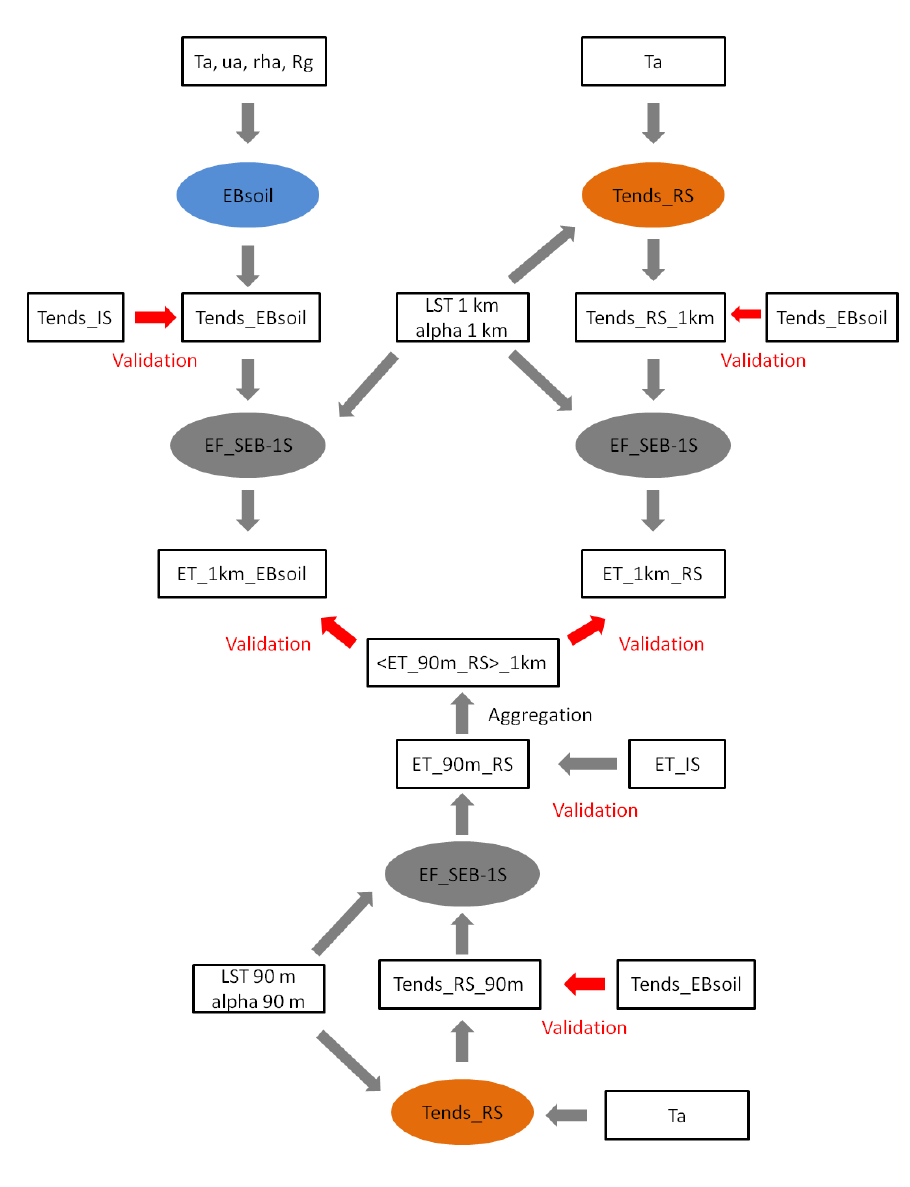
Figure 6. Schematic diagram presenting an overview of the models used (including inputs, outputs and the relationships between them) and the validation strategy of temperature endmembers (Tends) and ET